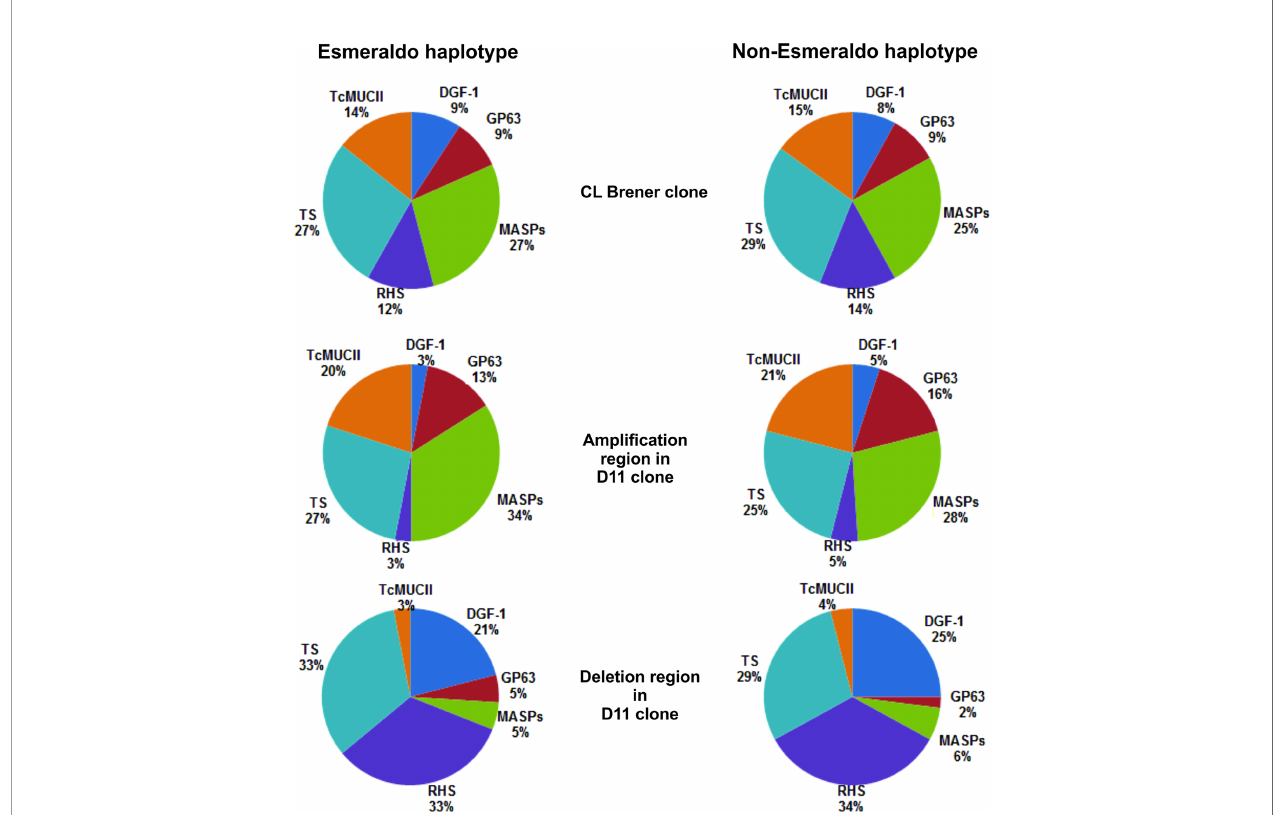
FIGURE 2 | Distribution of multigene families in the chromosomal alterations of clone D11. The distribution of multigene families in ampli fi cation and deletion regions was compared with the gene content of both haplotypes (Esmeraldo and non-Esmeraldo) of the CLB reference genome. The CLB gene contents were compared with those in the ampli fi cation and deletion regions of clone D11: TS, Trans-Sialidase; TcMUCII – T. cruzi Mucin II; DGF-1, Dispersed Gene Family 1; Gp63; MASP – Mucin Associated Surface Protein; RHS, Retrotransposon Hot